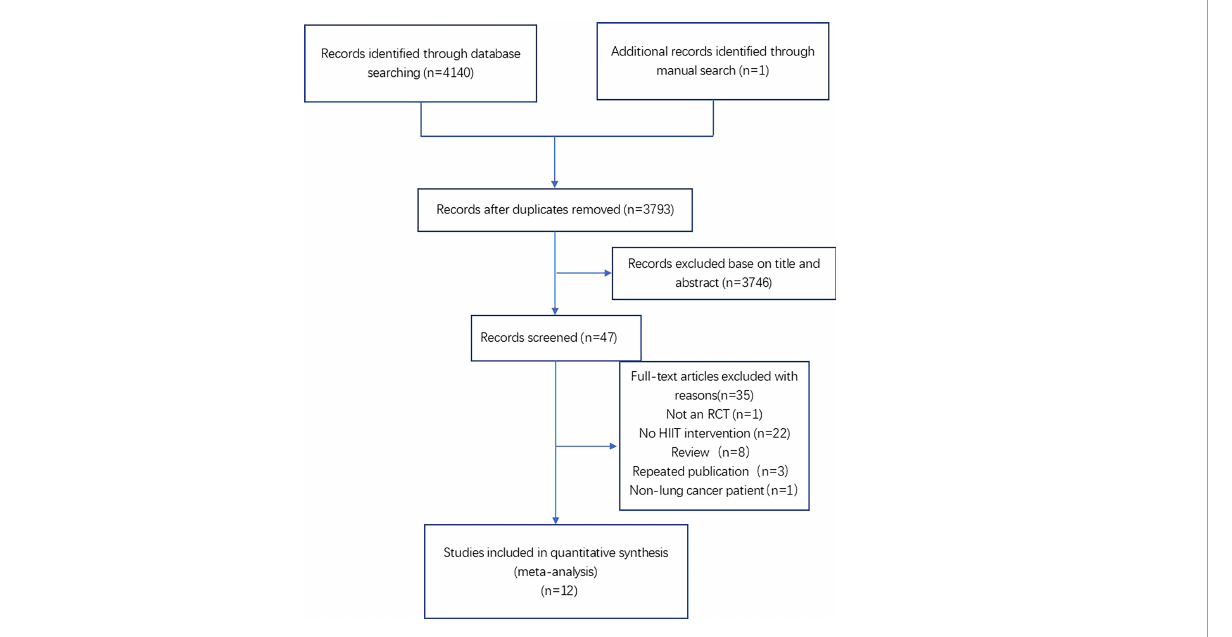
FIGURE 1 Flow diagram of the selection of